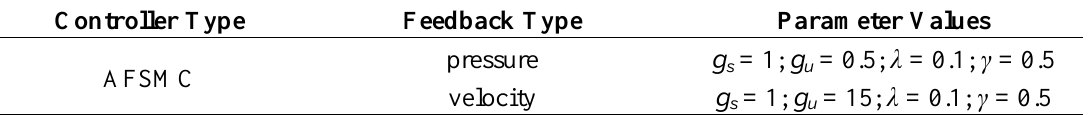
Table 1. Values of control parameters used in AFSMC.